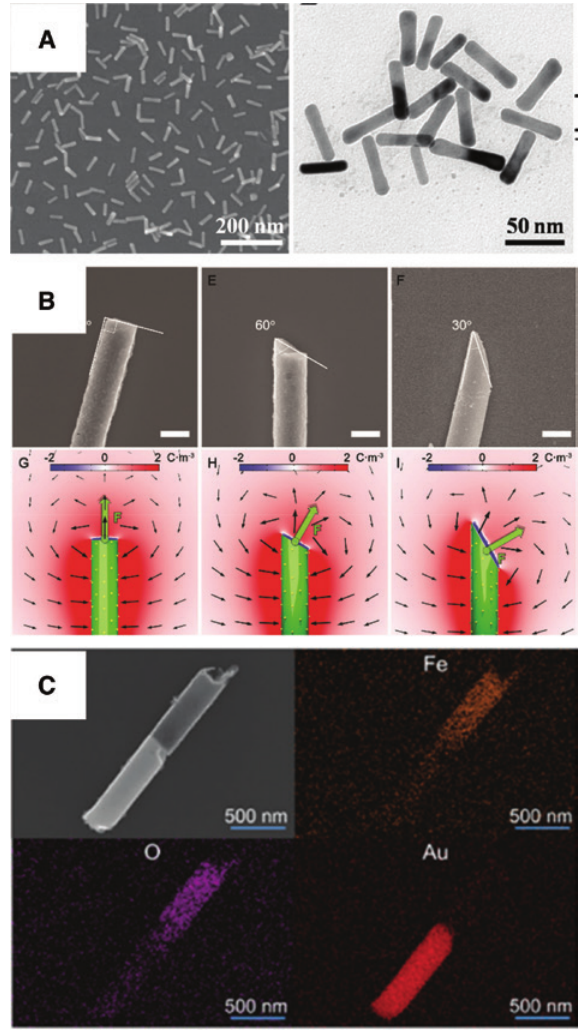
Figure 8: Various nanorod structures of light-driven micro/ nanomotors. (A) SEM and transmission electron